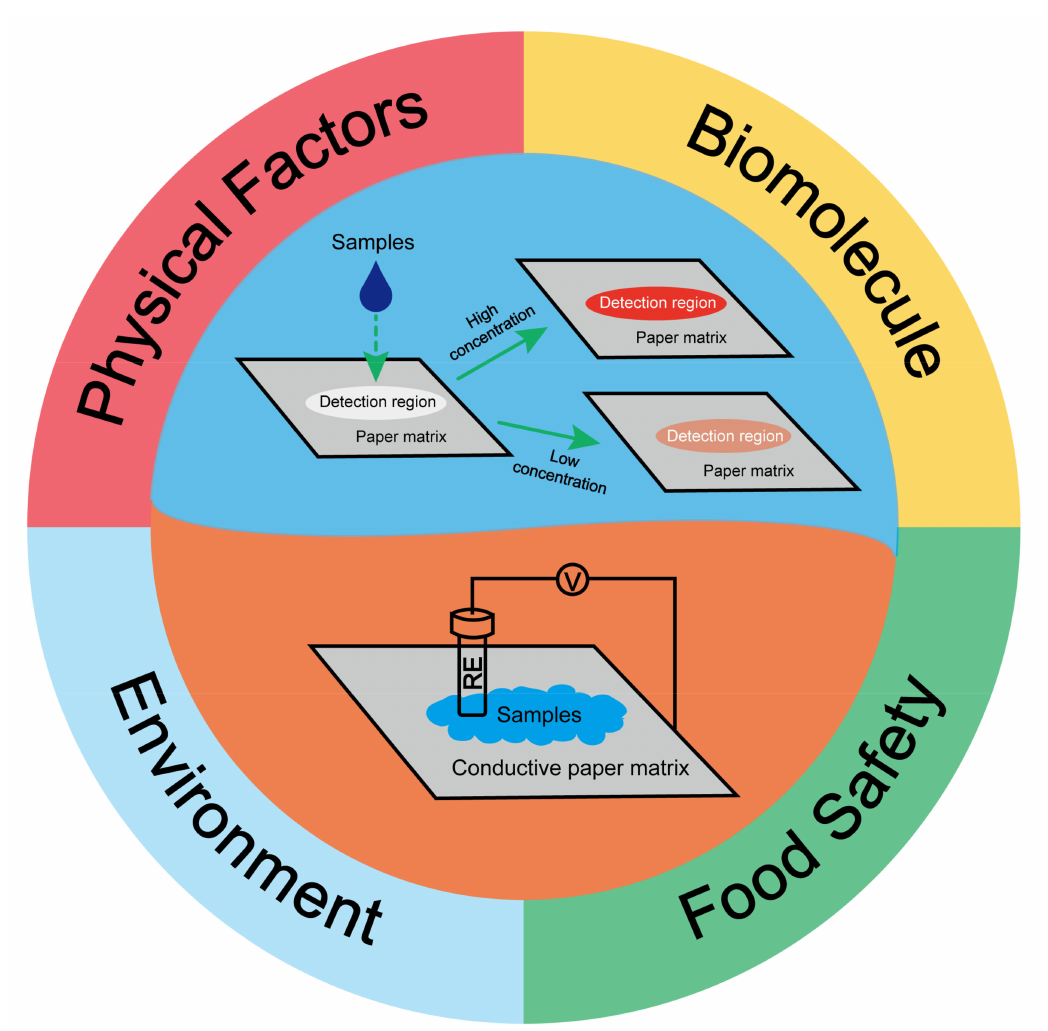
Figure 1. Paper-based sensors for physical factors, biomolecule, food safety, and environment detection based on the optical or electrical signal